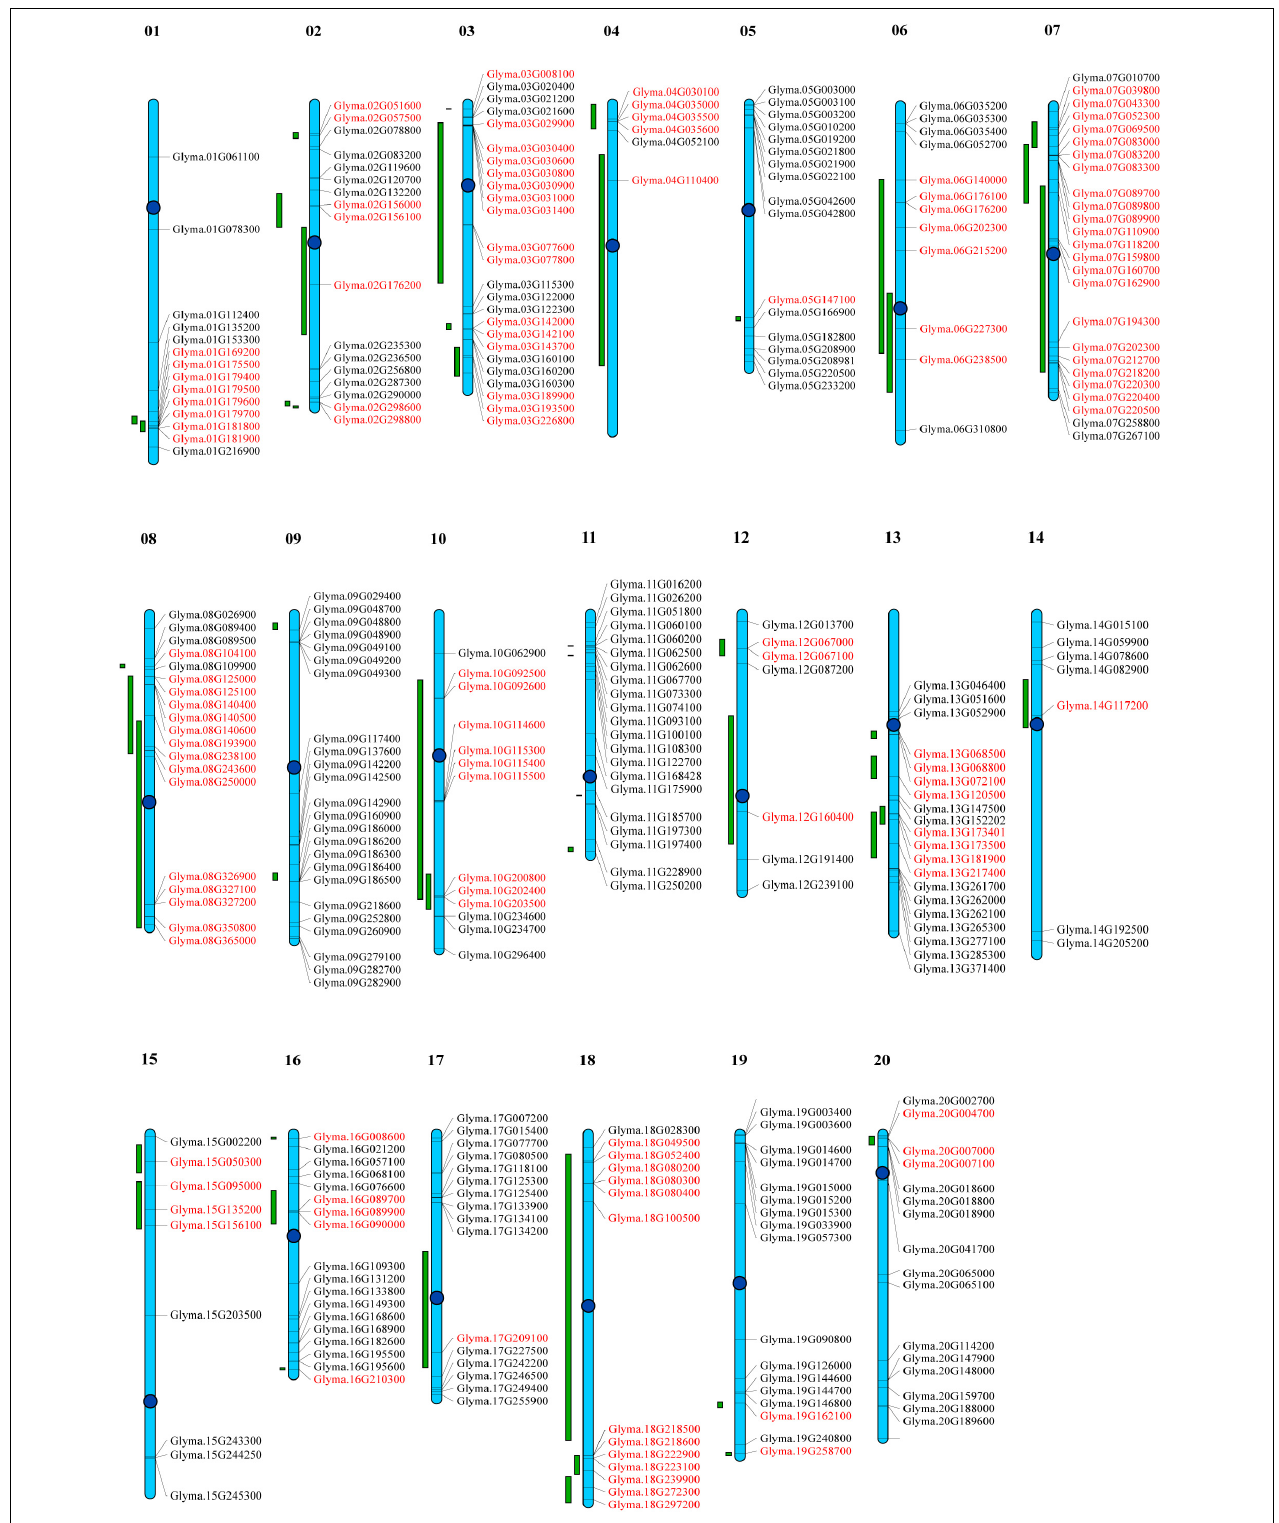
FIGURE 6 | Distribution of all GmP450 genes in soybean chromosomes and quantitative trait loci (QTL) associated with resistance against Phytophthora sojae . Chromosomes are drawn to scale and chromosome numbers are indicated above each chromosomes. Centromeres are indicated by blue circles. Green bars indicate QTL regions associated with resistance against P. sojae . Candidate GmP450s within the QTL region are indicated in red.